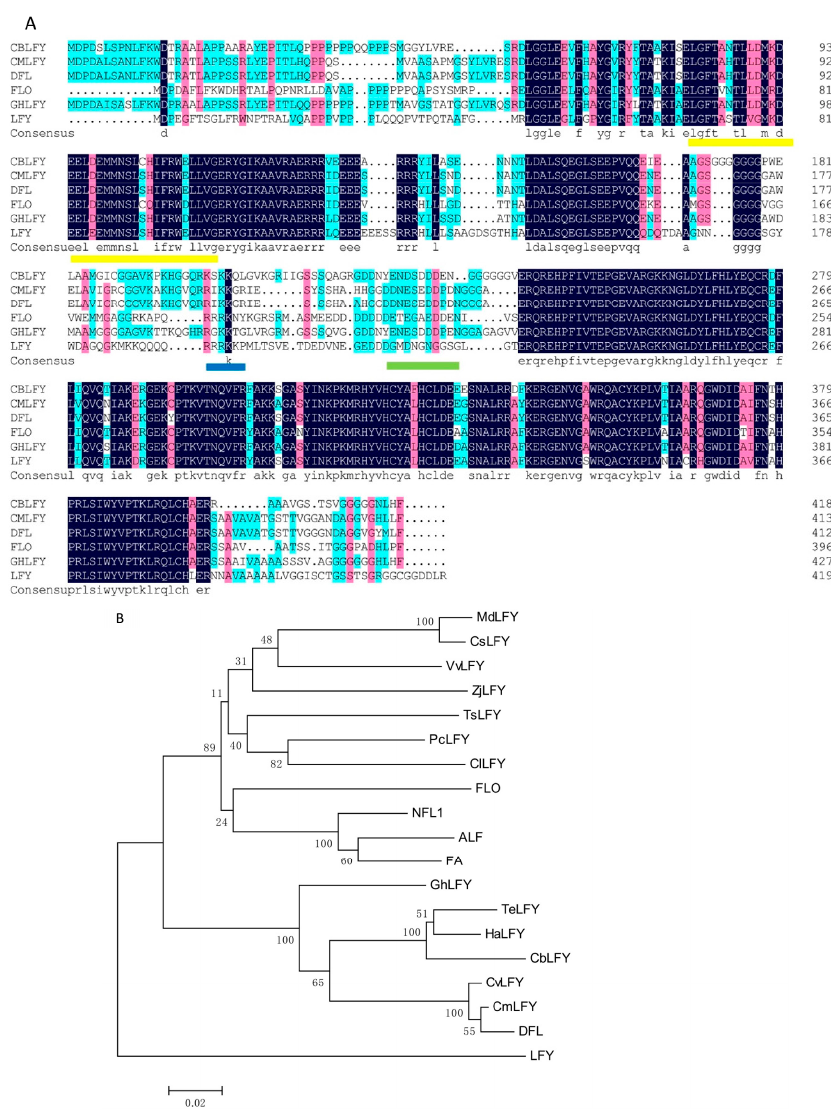
Figure 4. Multiple sequence alignment ( A ) and phylogenetic relationship ( B ) of CbLFY and LFY-like proteins. Identical amino acid residues in this alignment are shaded in blue; similar amino acid residues are shaded in red; the Leu zipper is indicated by a yellow underline; the acidic region is indicated by a blue underline; the basic region is indicated by a green underline; the sequences included in the analysis have the following accession numbers: CmLFY (Chrysanthemum × morifolium BAN19220.1), DFL (Chrysanthemum lavandulifolium AAT51708.1), FLO (Antirrhinum majus subsp. majus AAA62574.1), GhLFY (Gerbera hybrid cultivar ANS10152.1), LFY (Arabidopsis thaliana AED97525.1); ( B ) Phylogenetic relationship among FLORICAULA / LEAFY-like proteins. The protein sequences included in the analysis are TeLFY (Tagetes erecta AEG88962.2), CmLFY (Chrysanthemum × morifolium BAN19220.1),